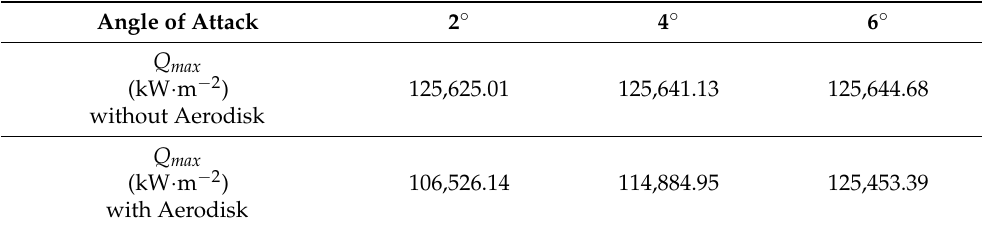
Table 4. Comparison of Q max with different angles of attack.